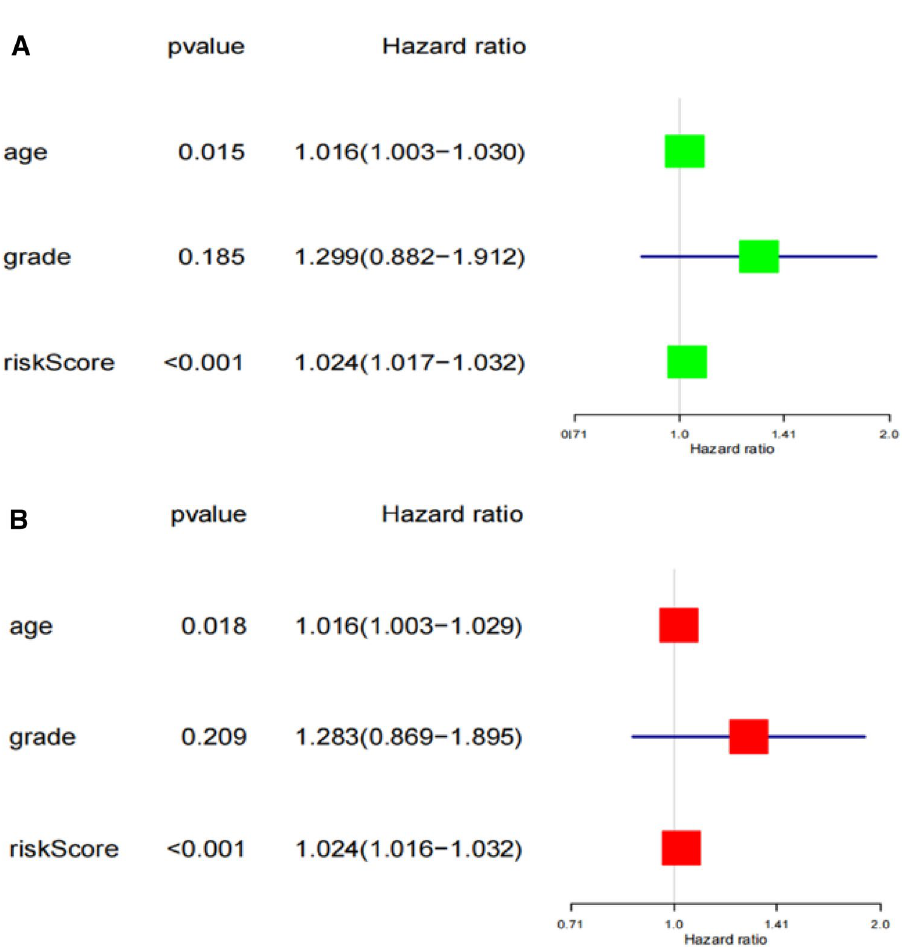
Figure 4. The prognostic value of age, stage, and risk score in OC. Univariate ( A ) and Multivariate Cox ( B ) regression analyses of the prognostic